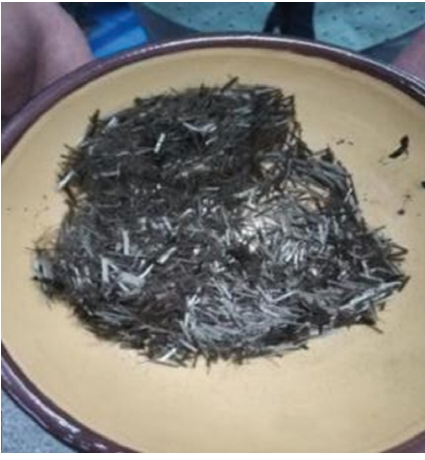
Figure 5: Basalt fiber.